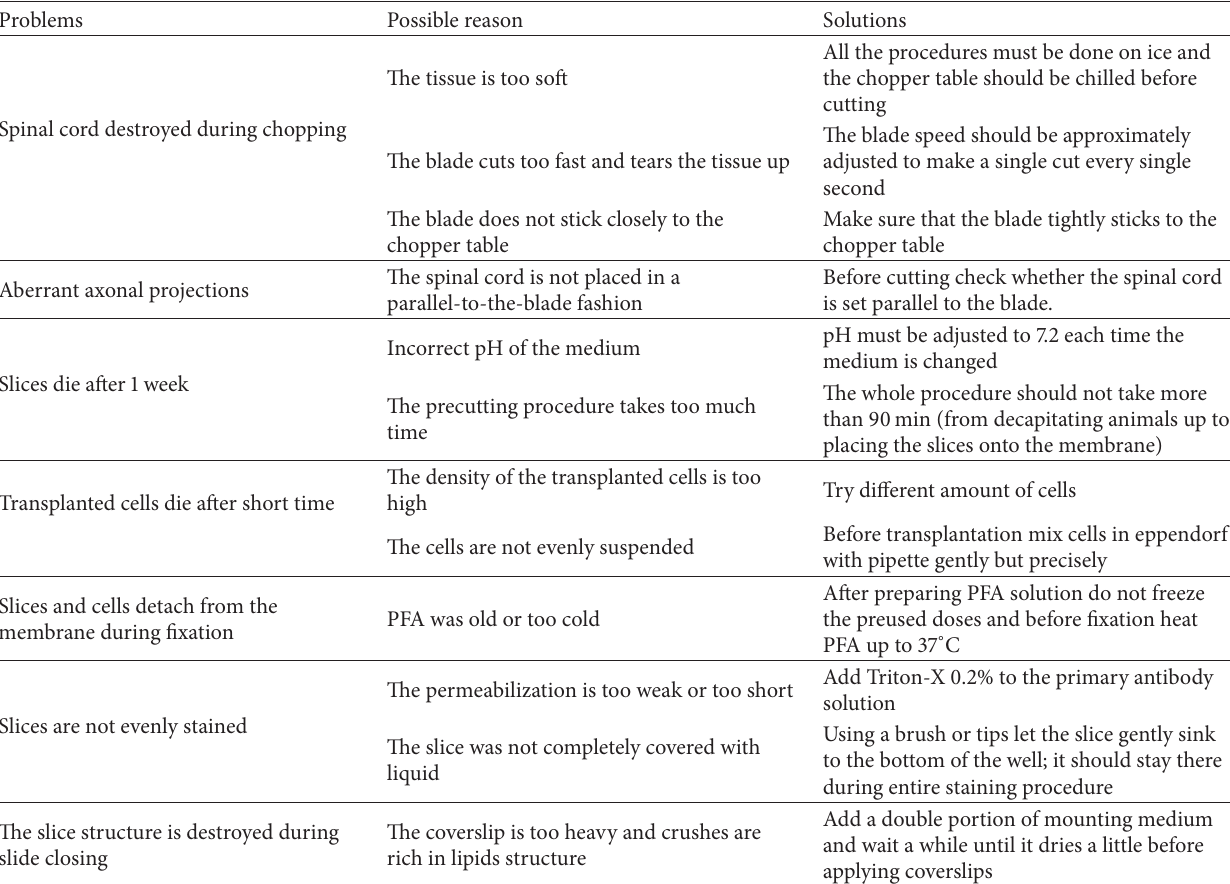
Table 1: Troubleshooting: the most frequent problems in preparing and maintaining the organotypic longitudinal spinal cord slice culture, their probable reasons, and their proposed